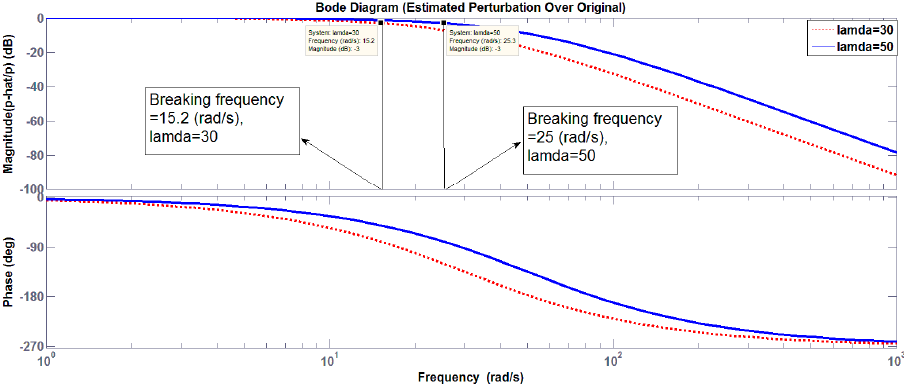
Figure 3. Bode plot of estimated perturbation over original perturbation.